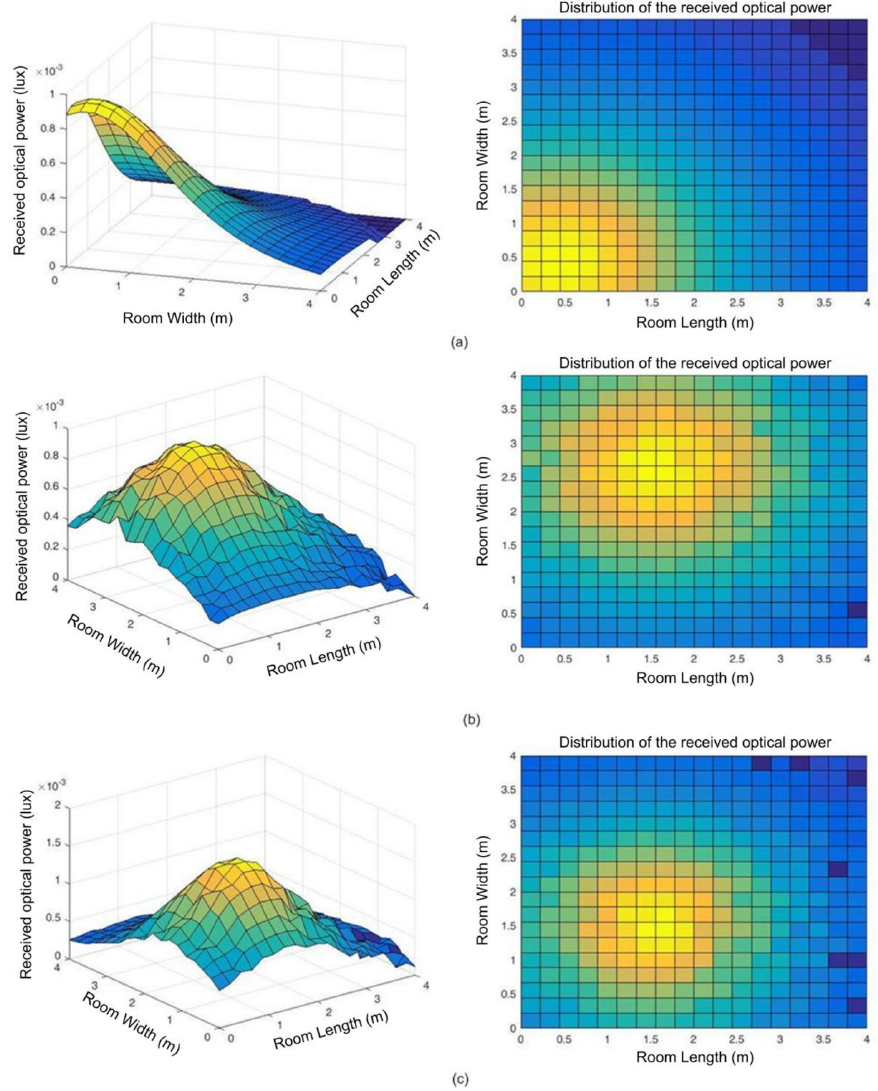
Figure 7. Examples of power distribution: ( a ) LED 1 is powered on and all receivers are pointed out to the ceiling; ( b ) LED 10 is powered on and all receivers pointed out with different angles; ( c ) LED 6 is powered on and all receivers pointed out with random angles and three reflections are taken into account at